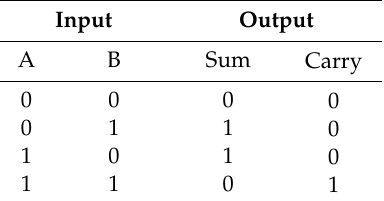
Table 1. Truth table of half adder.